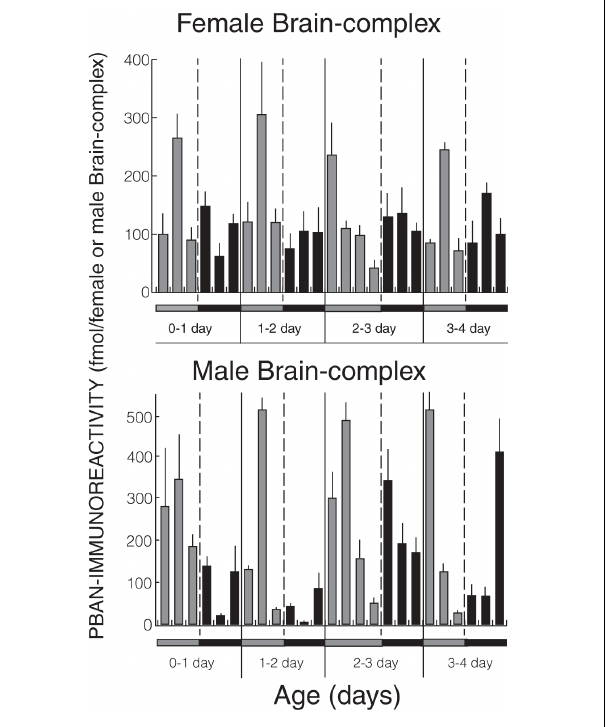
FIGURE 4 | Pheromone biosynthesis activating neuropeptide-immunoreactivity in the brain-subesophageal ganglion-corpora cardiaca-corpora allata complexes of Helicoverpa armigera males (Hirsch, 1991) and females (Rafaeli et al., 1993). Histograms represent means ± SE of eight replicates each of a pool of at least five tissue equivalents. Gray bars, photophase period; black bars, scotophase